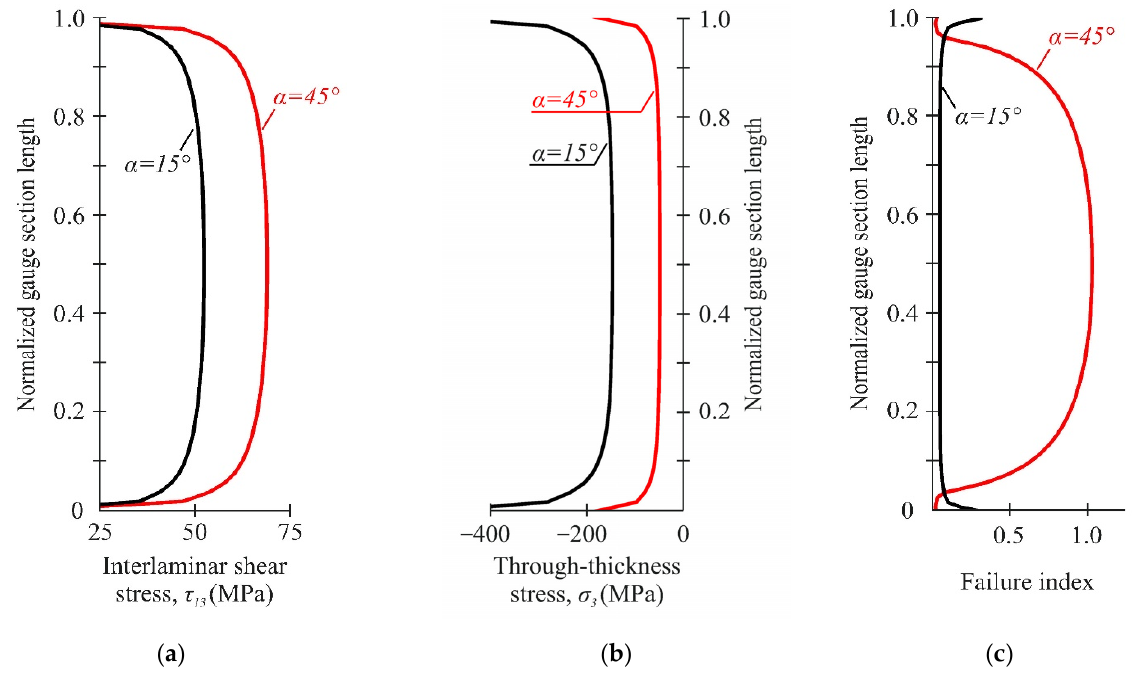
Figure 10. Distribution of interlaminar shear stresses ( a ), through-thickness stresses ( b ), and failure indexes NU-Daniel ( c ) between the notches at different loading angles.